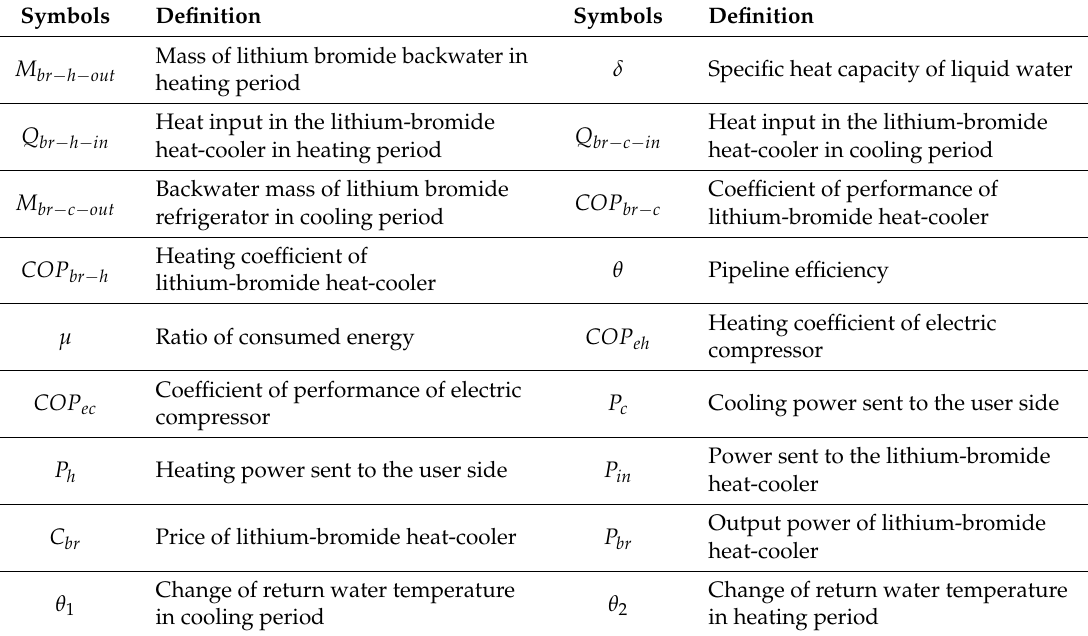
Table 4. Definition of the symbols in lithium bromide formula.